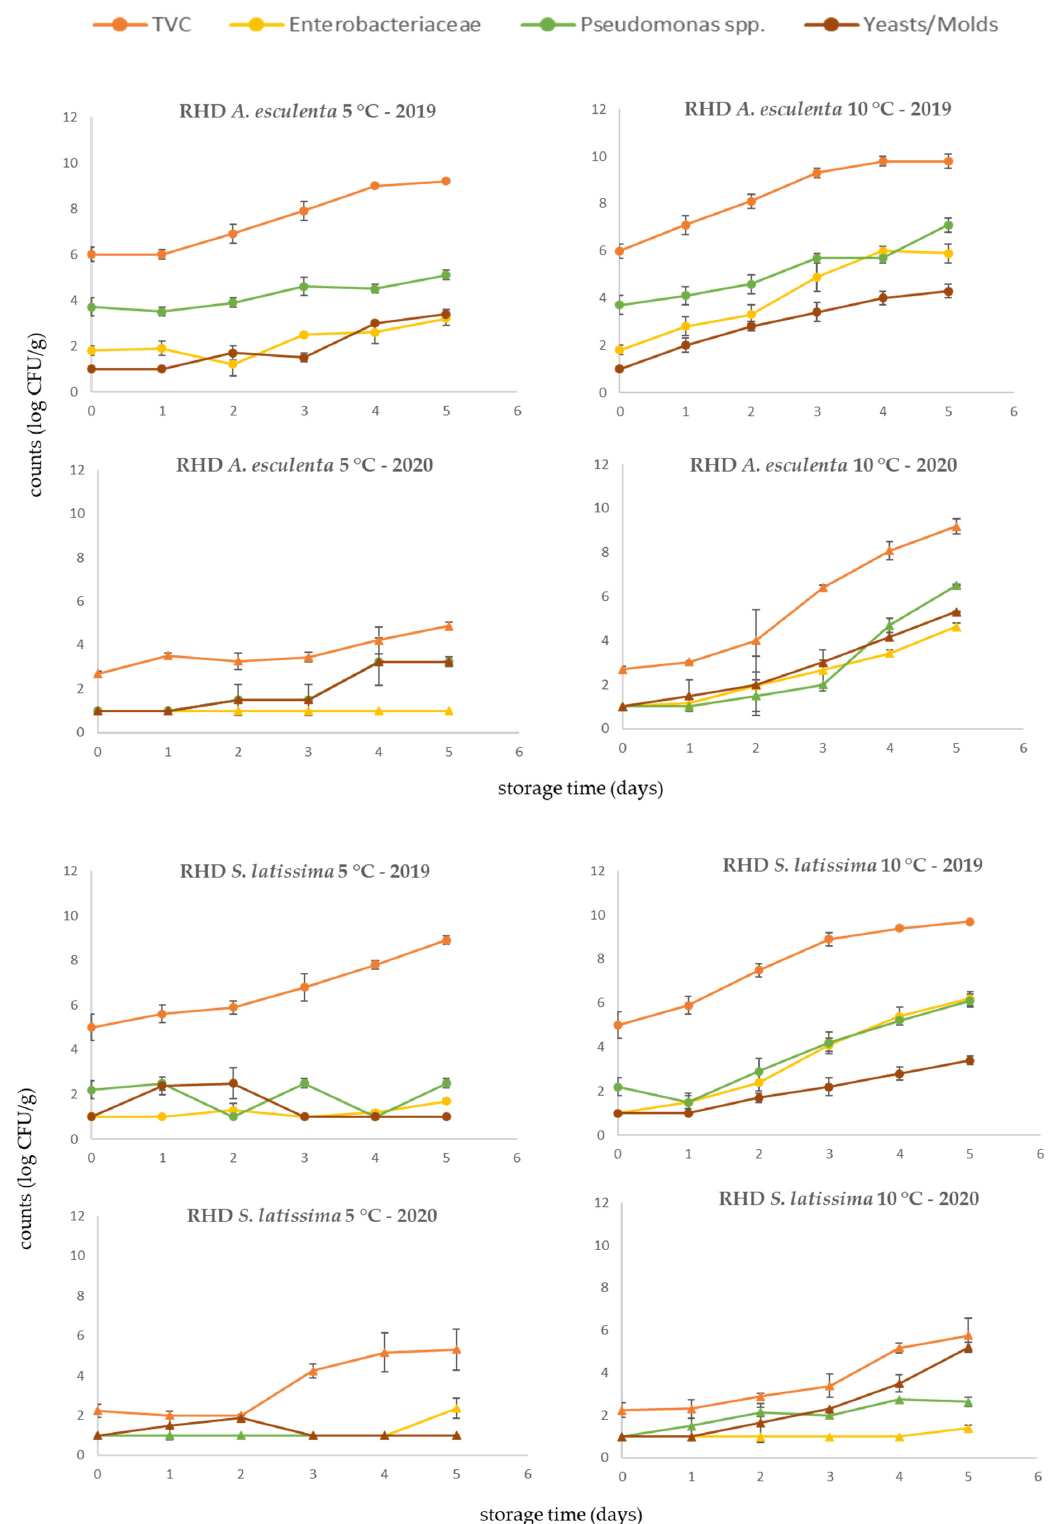
Figure 5. Microbial populations of rehydrated (RHD) seaweeds A. esculenta and S. latissima in 2019 and 2020 harvest years, stored at 5 and 10 °C.